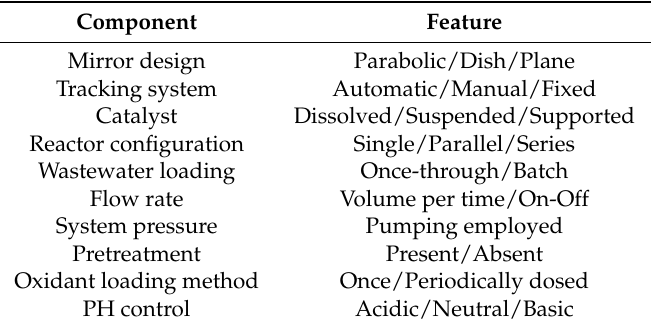
Table 1. Design factors for a solar wastewater remediation